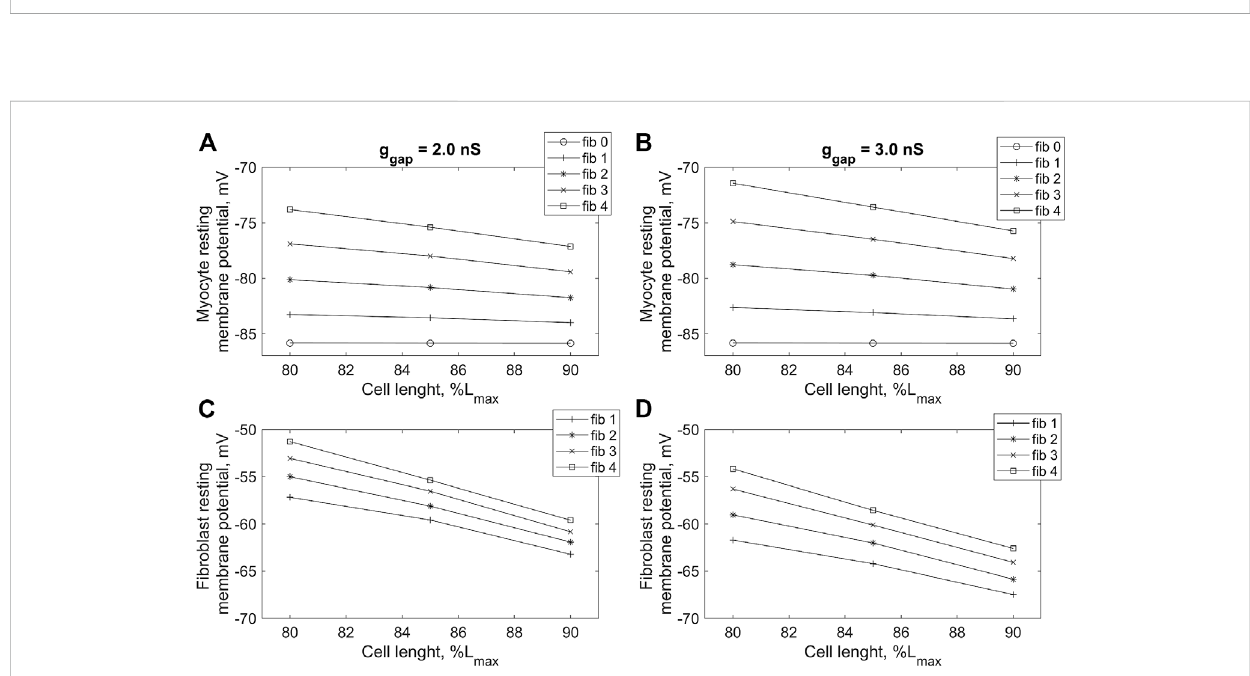
FIGURE 6 Dependenceofrestingpotentialofcardiomyocyte (A,B) and fi broblasts (C,D) oninitialcardiomyocytelengthduringisometriccontractionsin model 2 with different numbers of connected fi broblasts ( n = 0, ... , 4), and gap junction conductances: ɡ gap = 2.0 nS (A,C) and ɡ gap = 3.0 nS (B,D) . The initial cardiomyocytelength was setat80%, 85% and 90% of L max (where L max isthe length atwhich thepeakactive isometric force of themyocyte reaches the maximum value). The stimulation frequency is 1